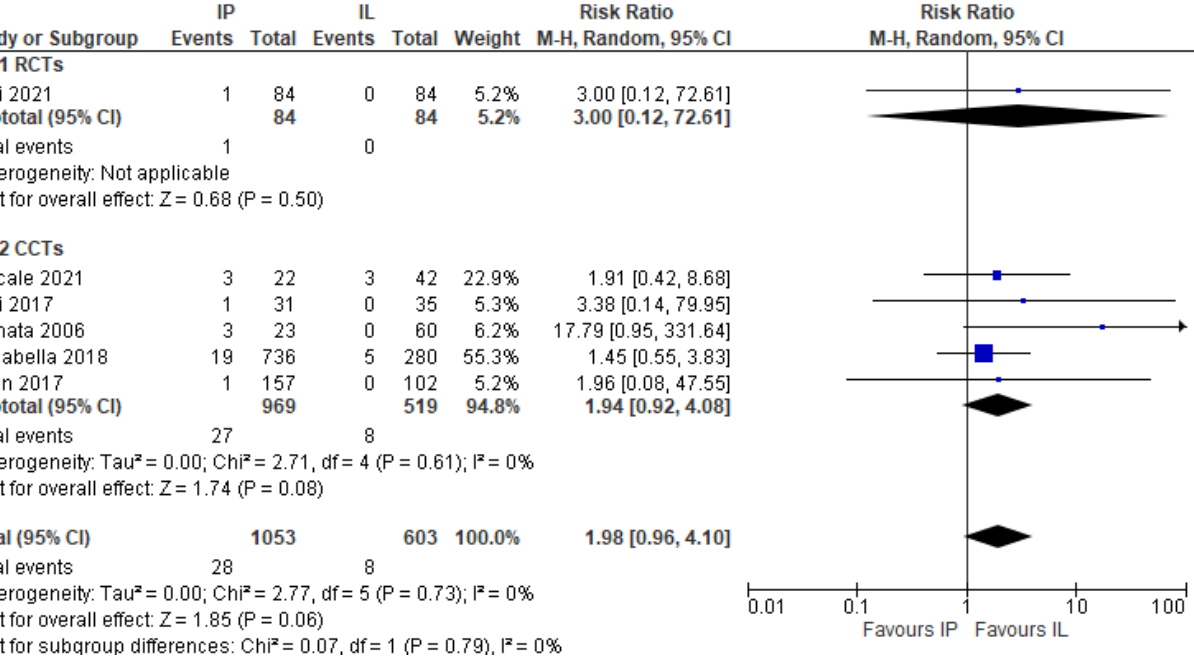
Figure 7. Post-operative rectal bleeding, risk ratio.